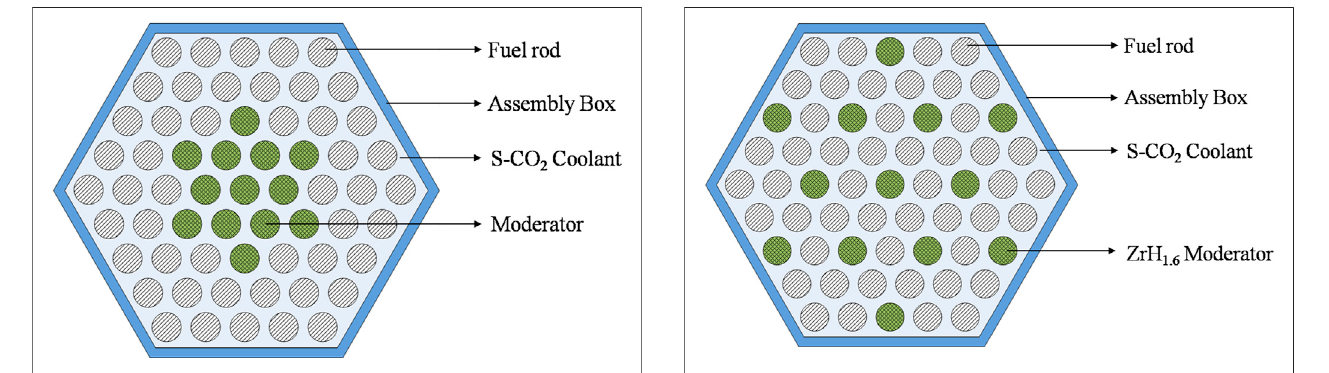
FIGURE 11 | S-CO 2 fuel assembly with moderator (compact arrangement).